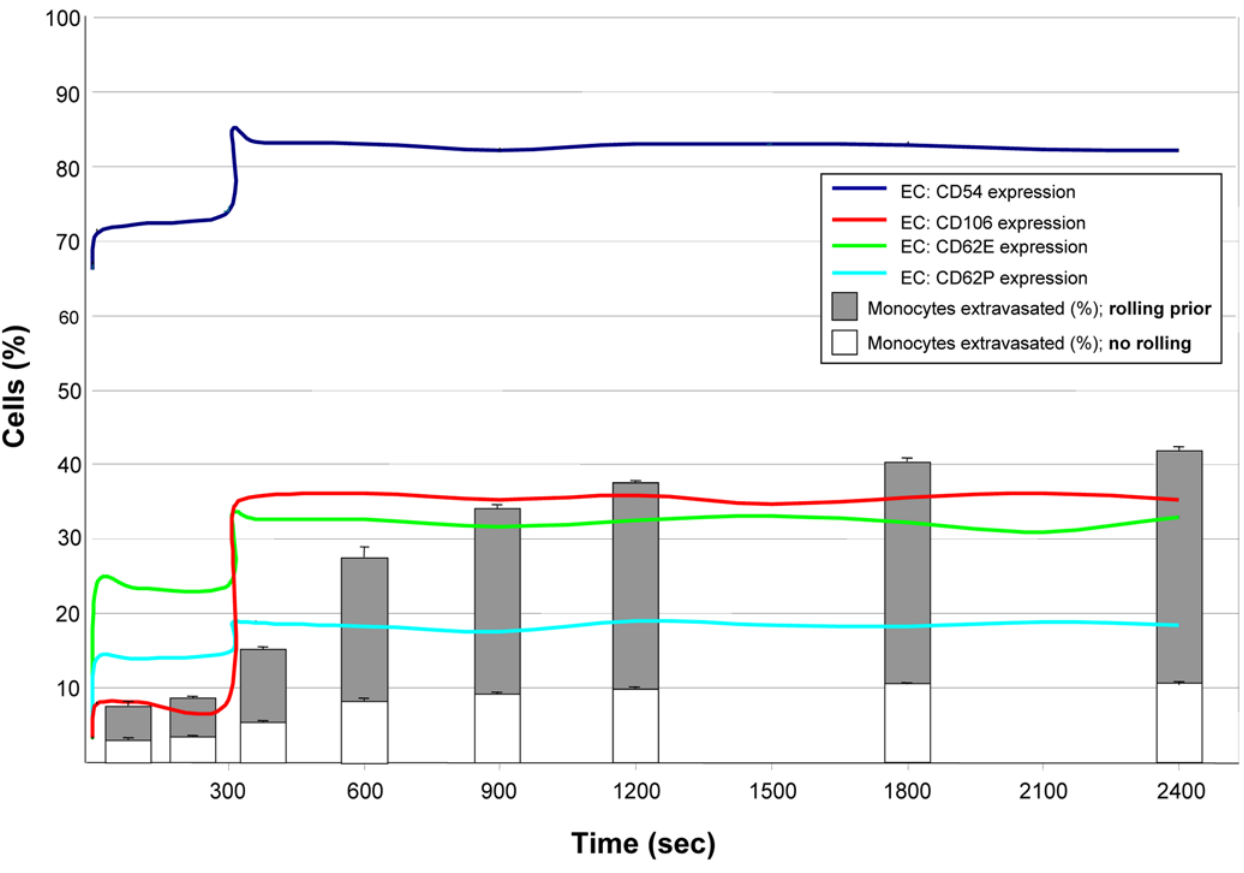
Figure 2. The ABM reproduced the rapid up-regulation of CAM and increased extravasation of monocytes that is characteristic of ischemic injury. Prior to injury at time=300, healthy endothelium maintained stable CAM expression and low monocyte extravasation. Injured endothelium increased expression of CD54 (ICAM-1), CD106 (VCAM-1), E-selectin (CD62e), and P-selectin (CD62p) following induction of injury (simulated by increasing pressure at sole feeder arteriole by 25%). Monocyte extravasation gradually increased (from 9% to 42%), as did the proportion of extravasated monocytes that rolled prior. All metrics stabilized by 2,400 seconds (40 minutes; n=5–9). Reported are mean extravasated monocytes + standard deviation. Colored lines depict endothelium CAM expression (average; lines fitted to discrete data points obtained on 10 second intervals).